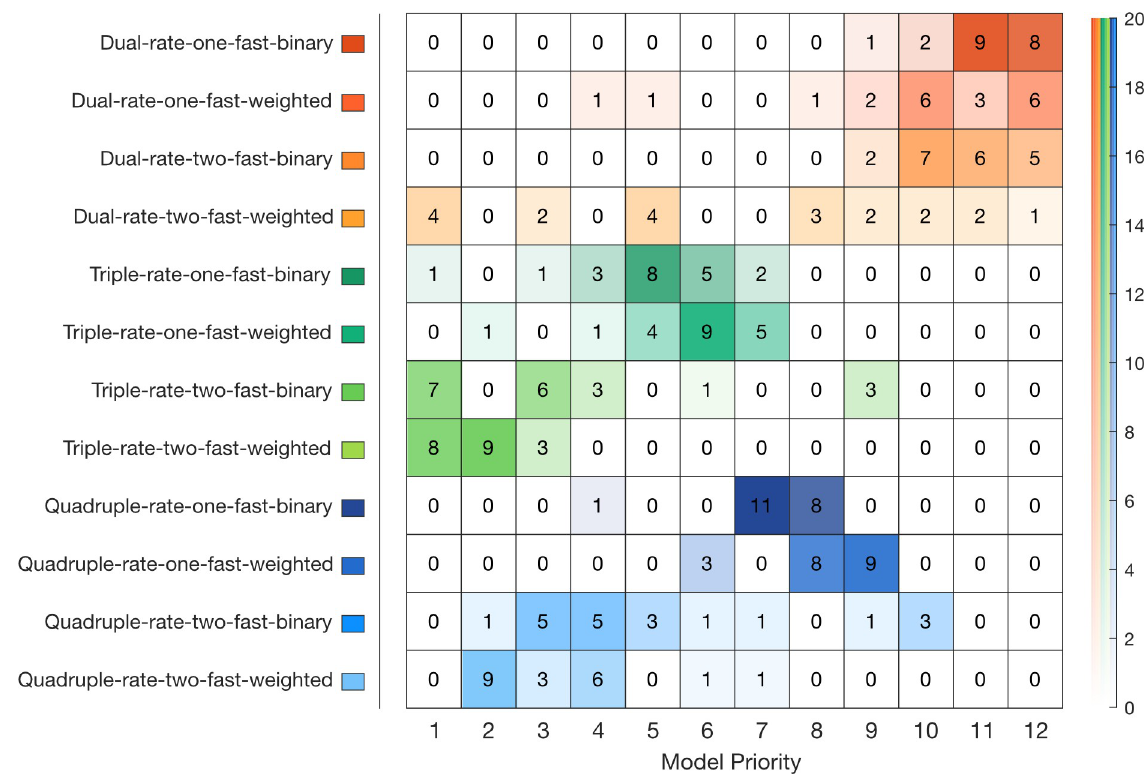
Fig 9. Frequency table of the individuals Bayesian Information criterion (BIC) model according to their priority (order of preference according to BIC improvement) across both experiments 1 and 2.